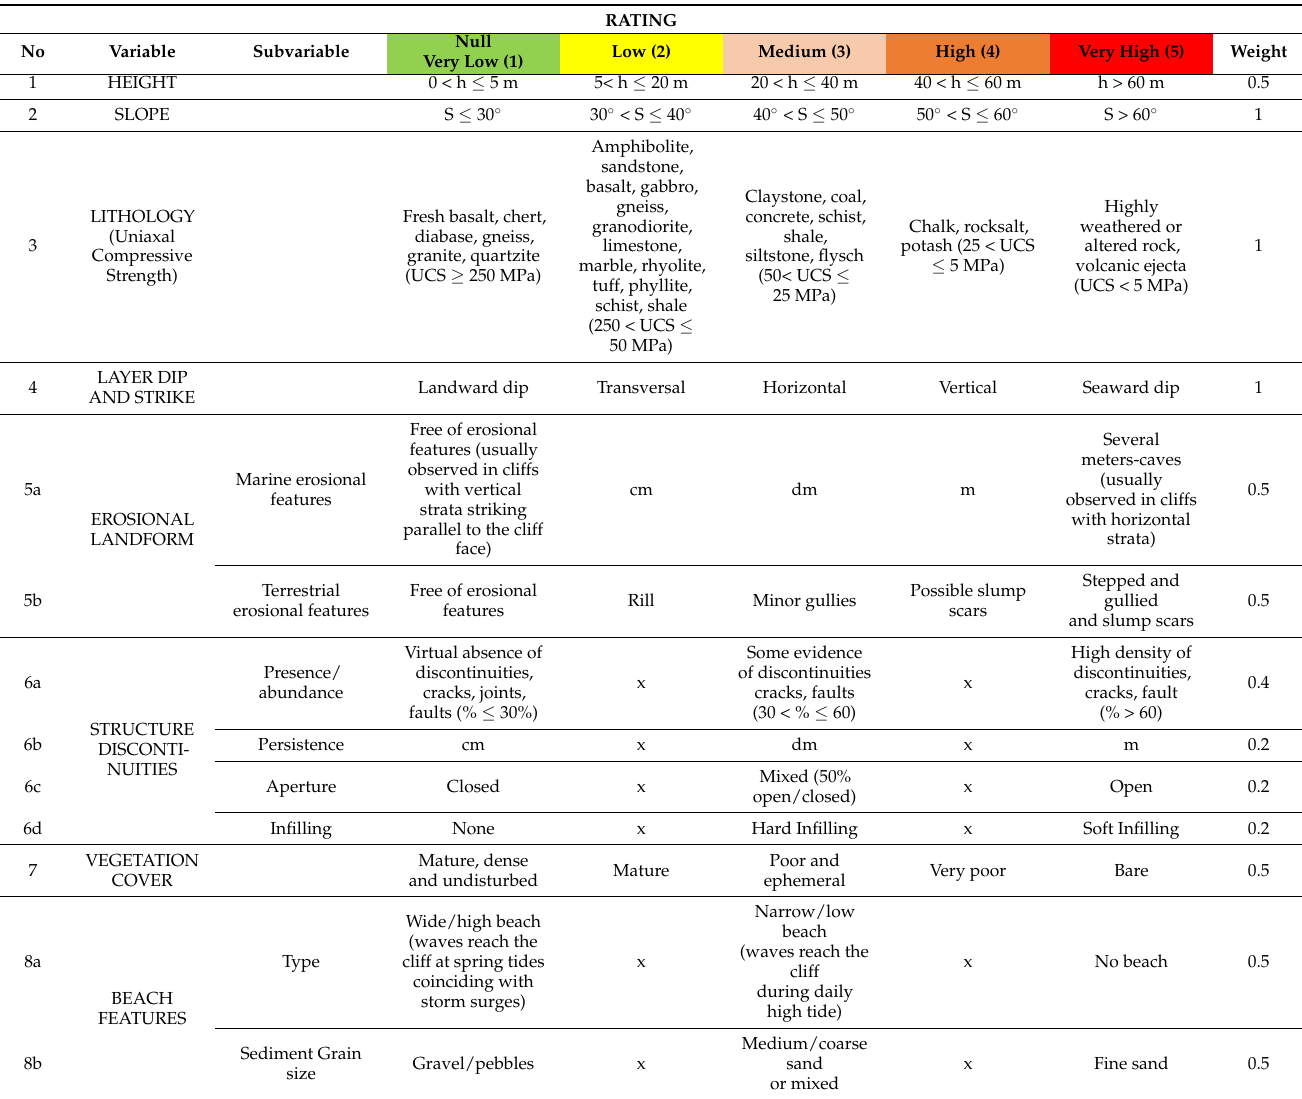
Table 1. Physical Elements Index rating from 1—minimum (green) to 5—maximum proneness (red) to